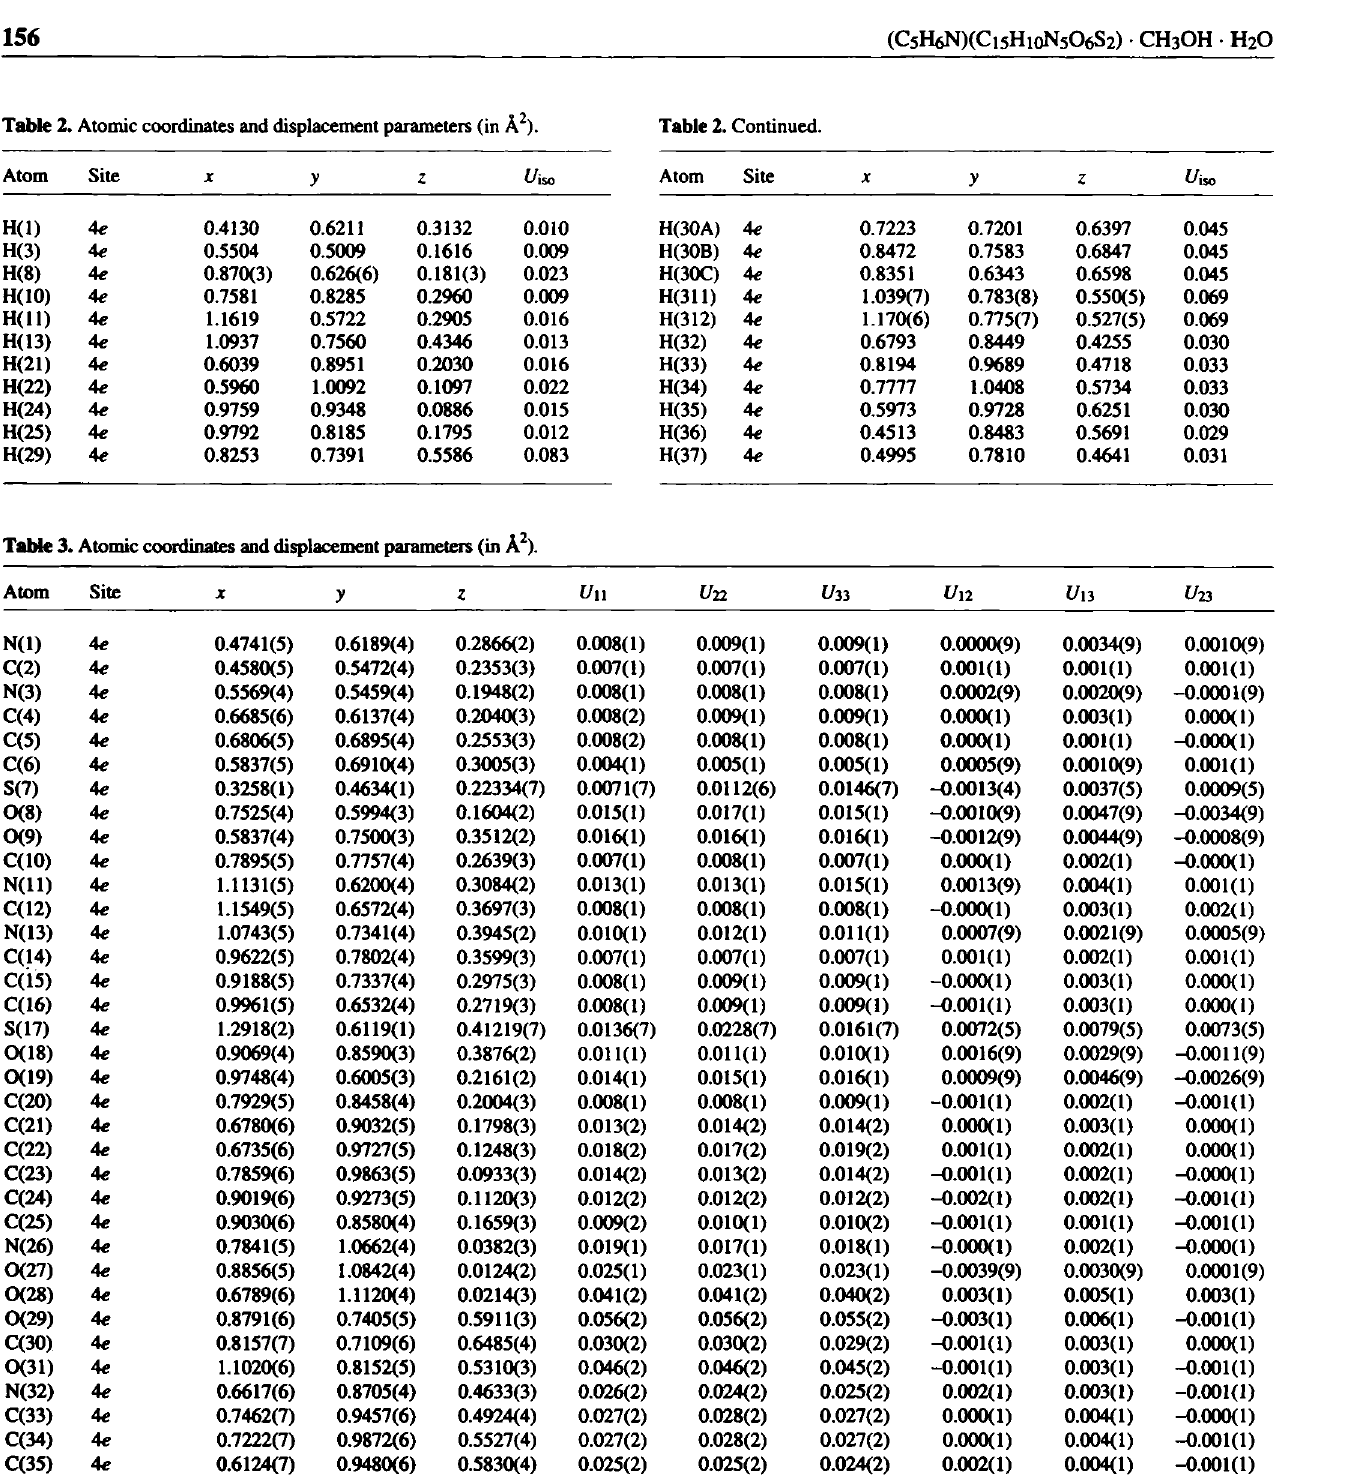
Table 2. Atomic coordinates and displacement parameters (in A 2 ).